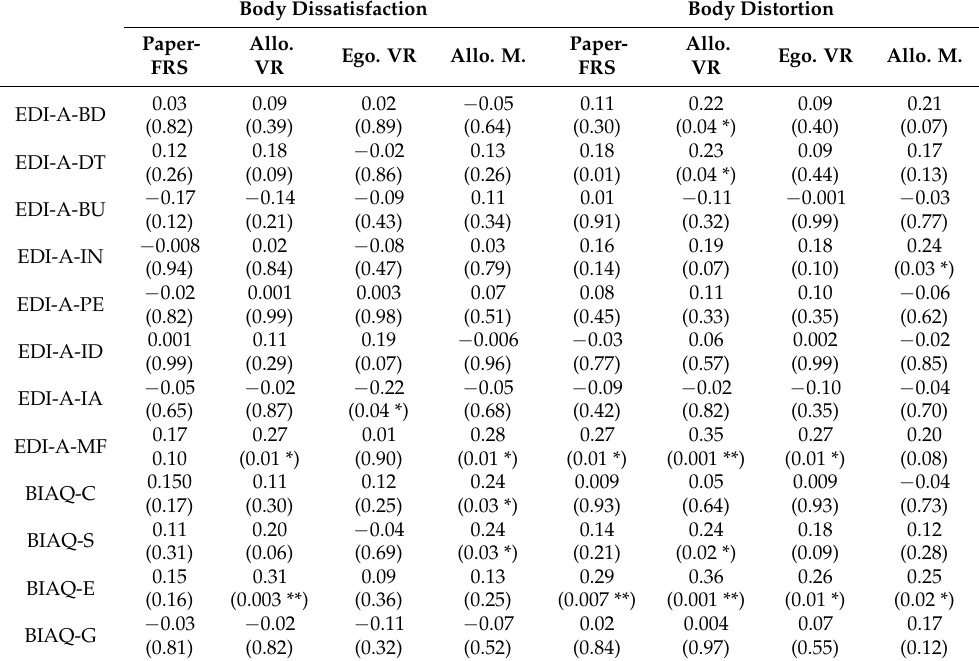
Table 4. Pearson’s correlations (with exact p values in brackets) for the subscales of questionnaires measuring components of BIDs and three rating scales administered to adolescents: a paper-based FRS, the e LoriCorps-IBRS 1.1 allocentric and egocentric perspectives, and the e LoriCorps-IBRS 1.1- Mobile allocentric perspective. Body Dissatisfaction Body Distortion Paper- Allo. Paper- Allo. Ego. Ego. VR Allo. M. FRS VR FRS VR